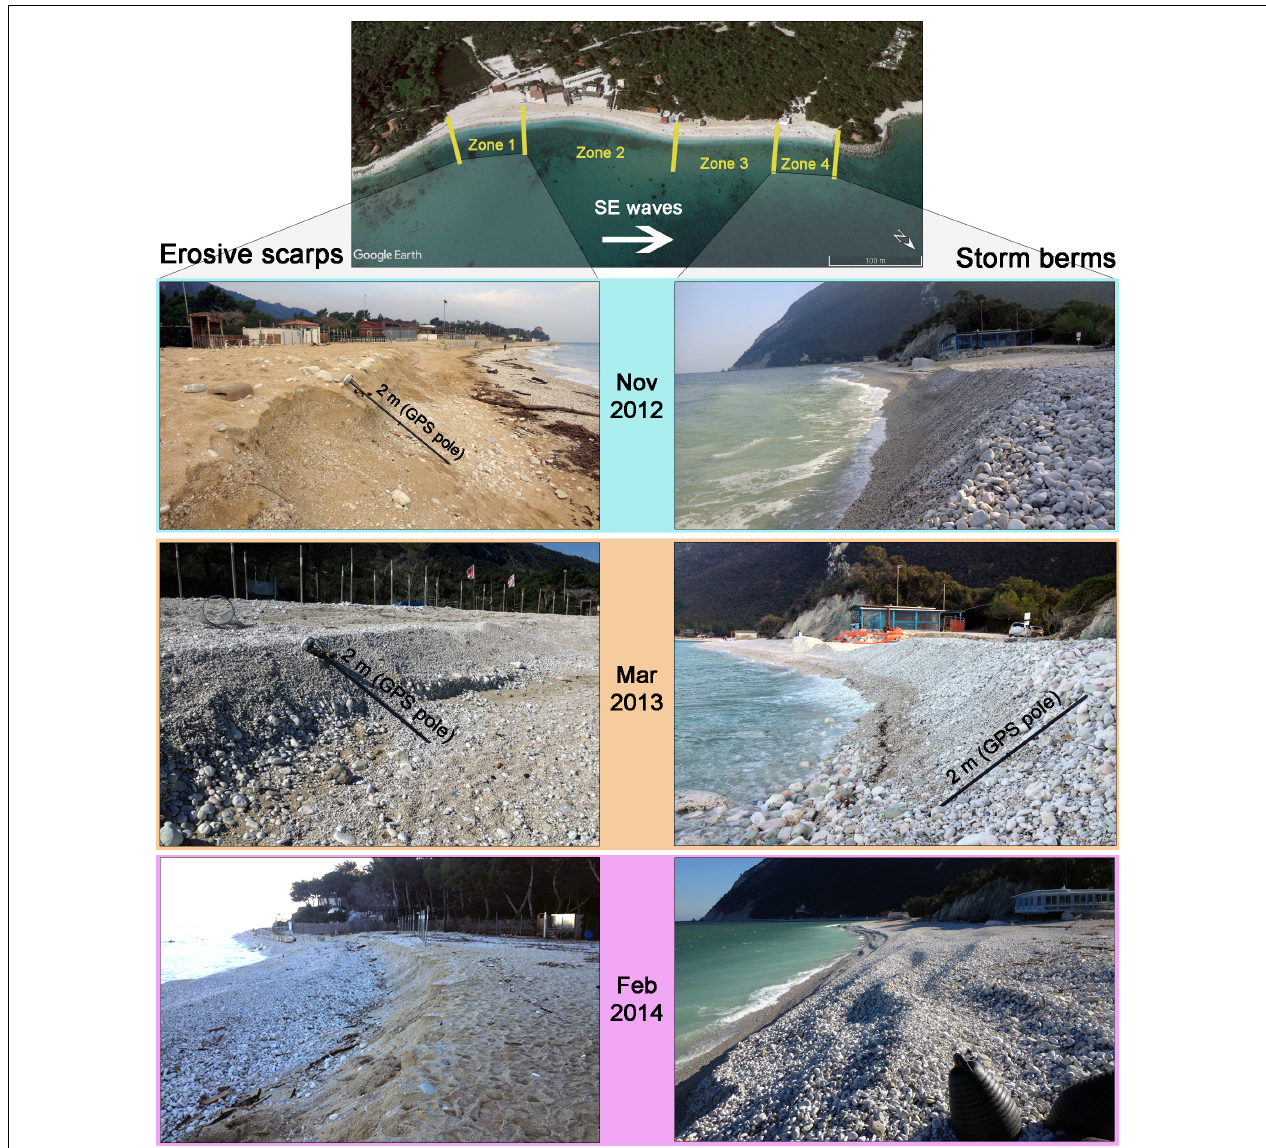
FIGURE 4 | Erosive scarps (on the left) and storm berms (on the right) from the edge zones of Portonovo beach after storm events from SE